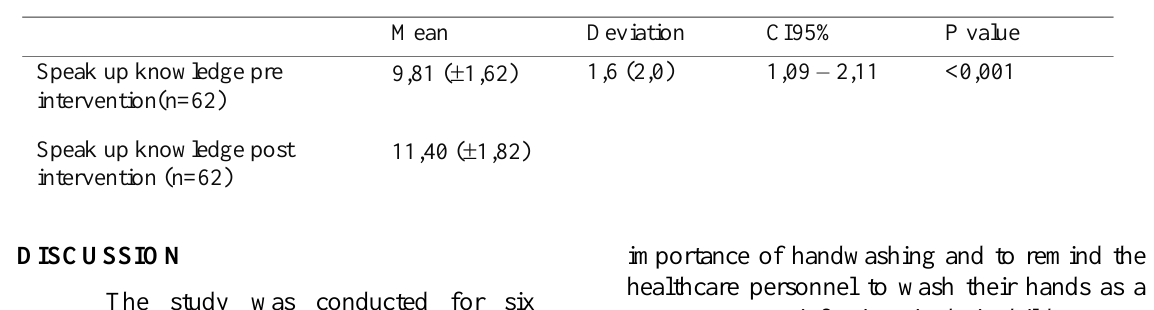
Table 2. Paired T-test results on parent‟s Speak up knowledge about patient safety pre